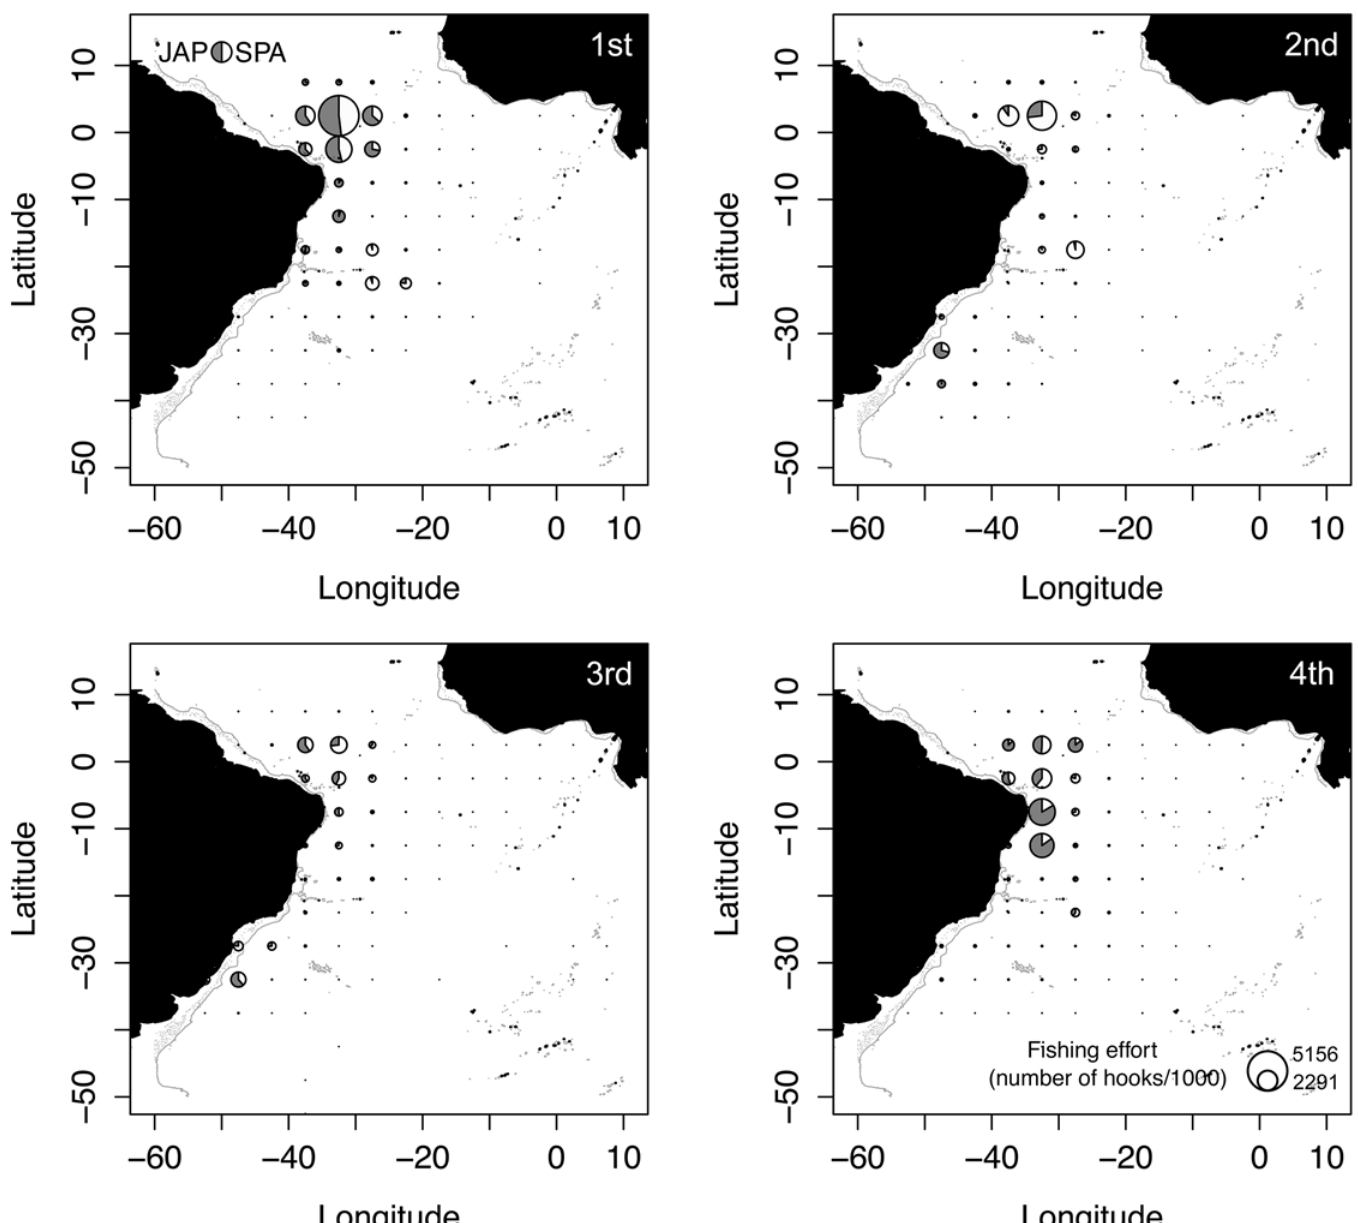
Fig 4. Fishing effort of the Brazilian longline fleet represented by the number of hooks deployed from 1999 to